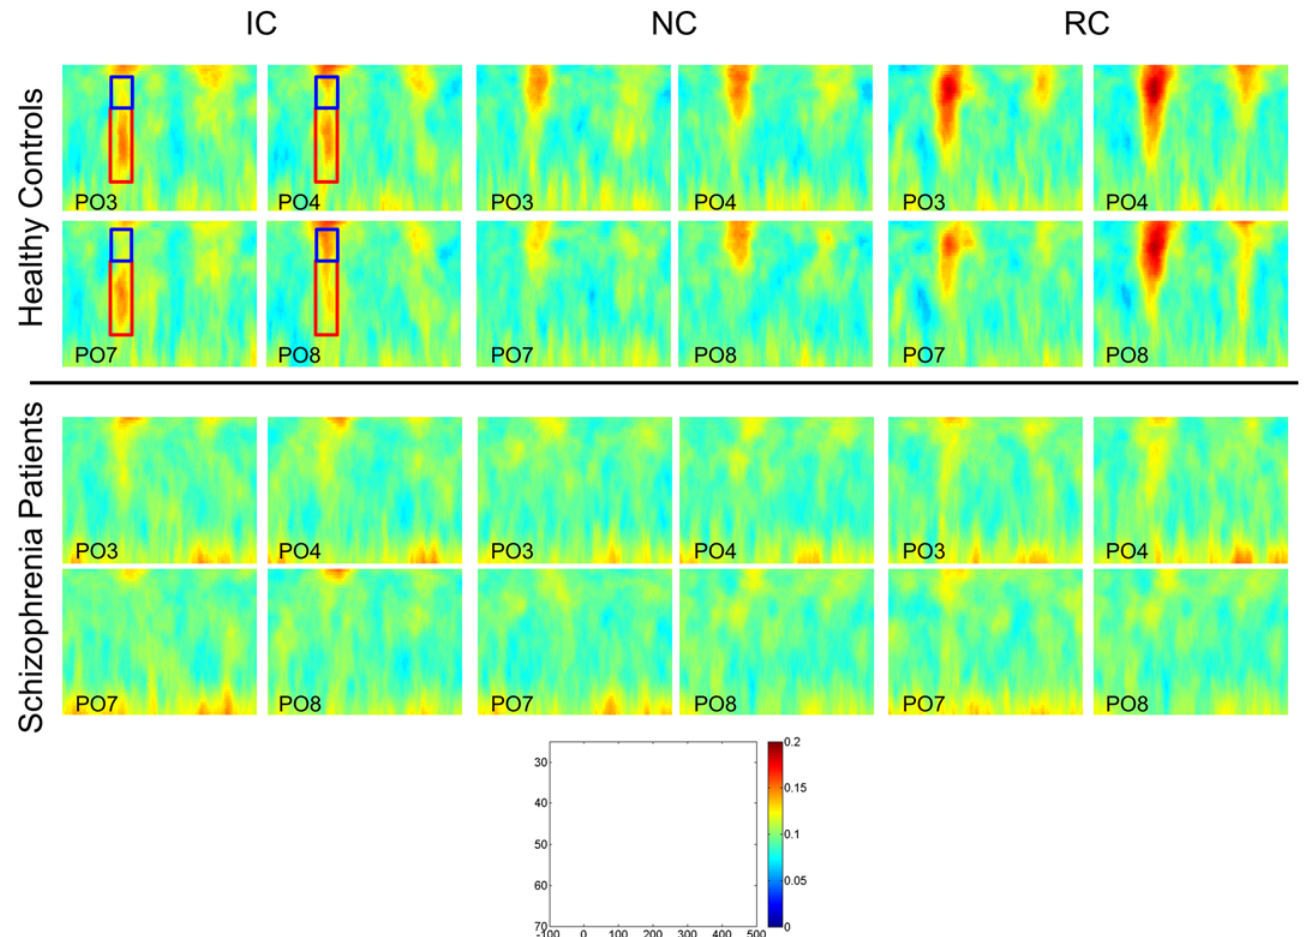
Fig 4. Time-frequency plots of phase locking factor for controls (top) and patients (bottom) for all three figure types. Plots from four representative electrodes (PO3, PO4, PO7, PO8) are shown. The scale for each plot is included. Frequency is plotted on the y-axis and ranges from 25 – 70 Hz (from top to bottom); time from onset of the stimulus is plotted on the x-axis and ranges from-100 to 500 ms. The blue box highlights the 30 – 40 Hz band and the red box the 40 – 60 Hz band that were